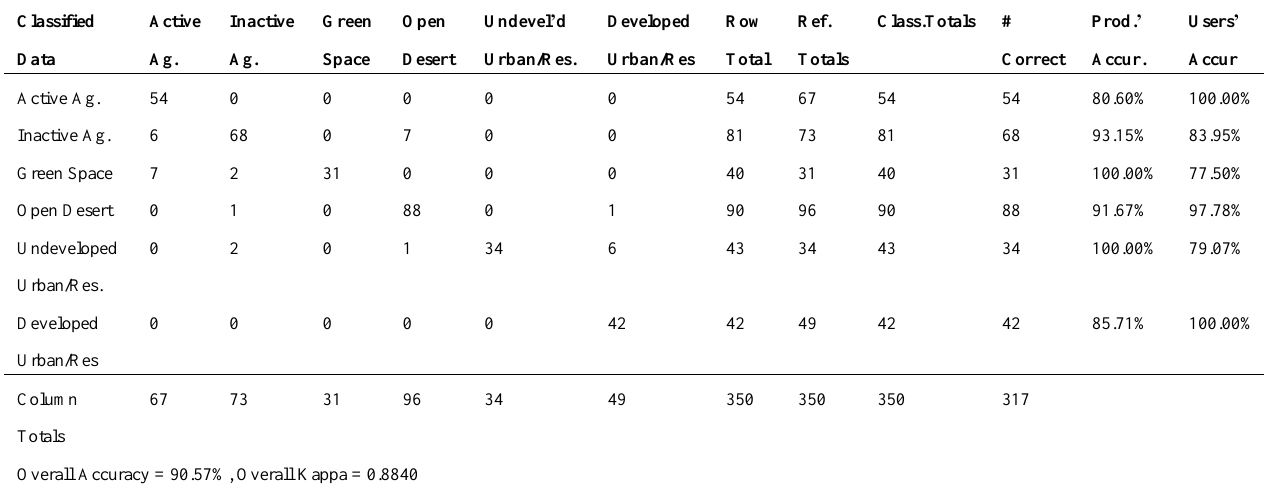
Table 2. Error matrix and classification accuracy—OBIA.